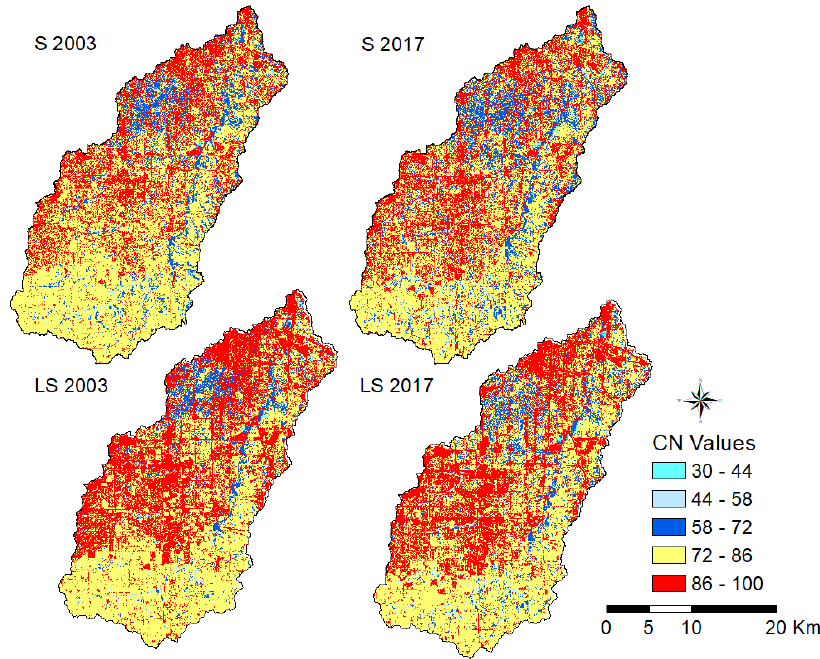
Figure 8. CN values estimated from SPOT (S) and LANDSAT (LS) LULC maps.